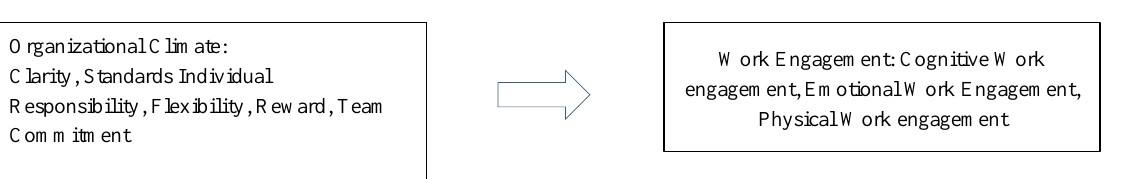
Figure 1: Conceptual Framework; Source: Hey Group (2003) and Drigo Consulting Group (2003) and Kuok and Taormina (2017)